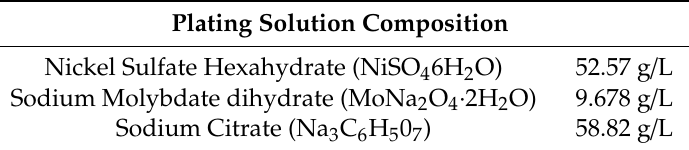
Table 2. Nickel–molybdenum alloy plating solution